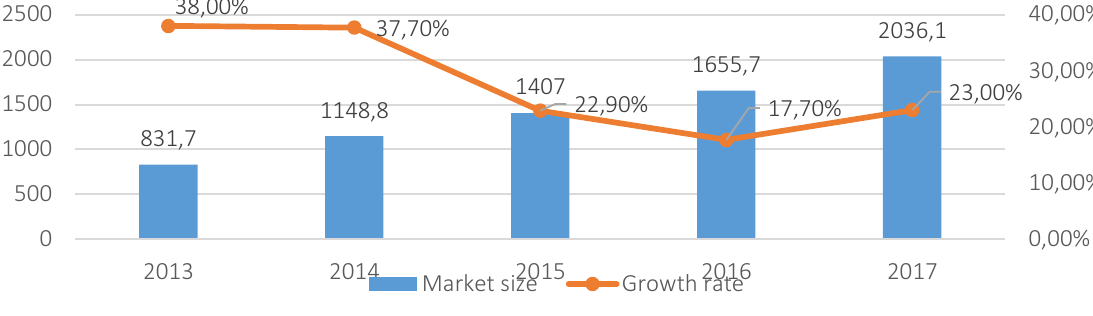
Figure 1. Market size of the Chinese game industry (unit: hundred million Yuan)